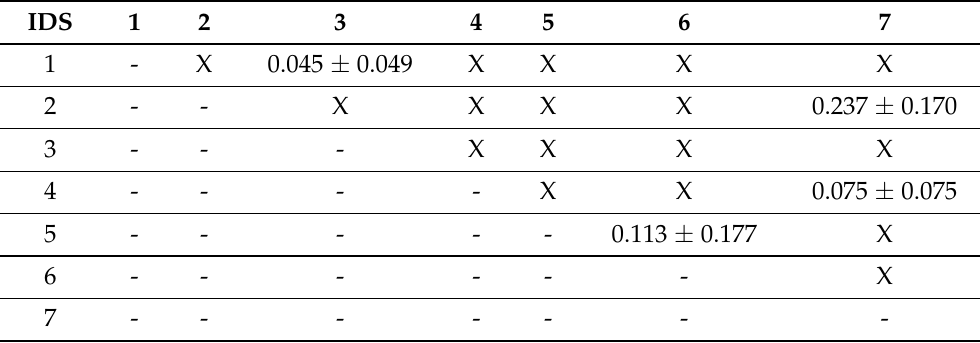
Table 2. Average TTC mean error and standard deviation over an entire sequence of all collisions for an example scene where “X” represents no crossing paths.